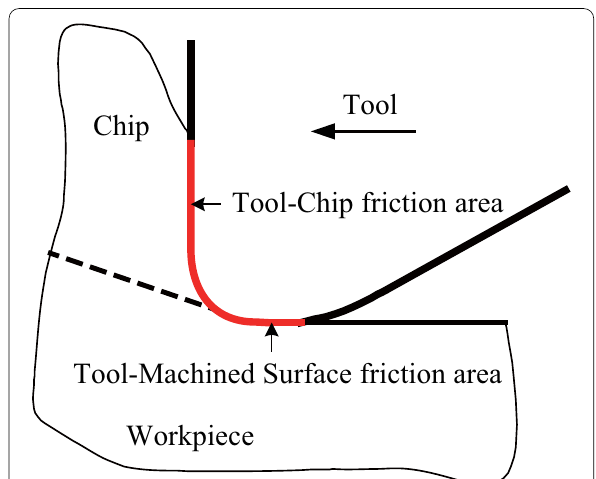
Figure 6 Illustration of friction area in the metal cutting process